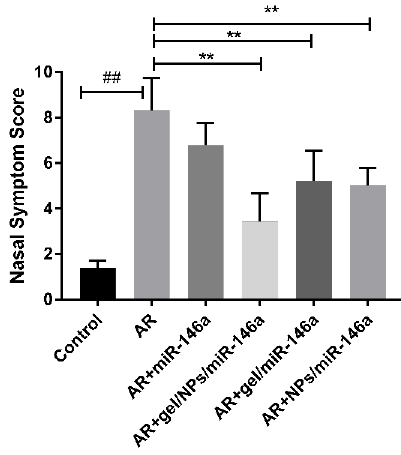
Figure 4. Nasal symptom score results. Each value represents the mean ± SD of the 6 rats in each group. ## p < 0.01 compared with the control group; ** p < 0.01 compared with the allergic rhinitis (AR) group.